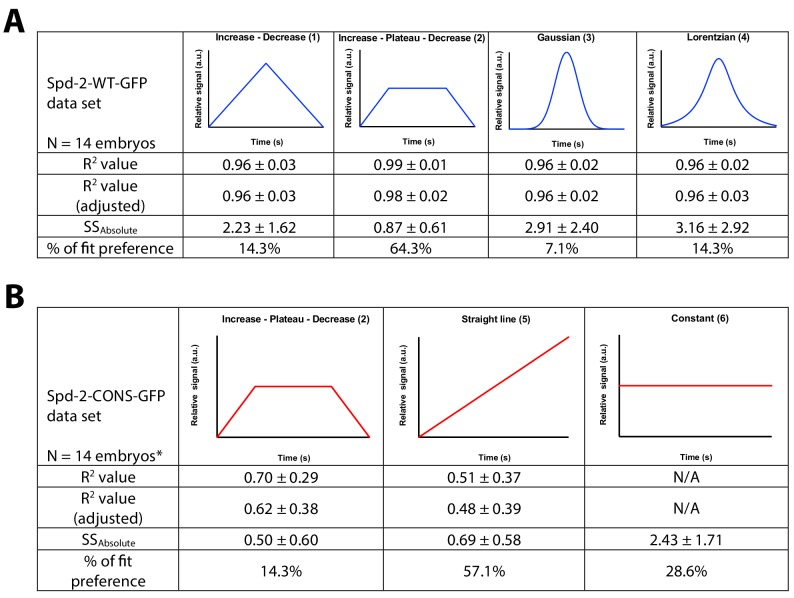
A schematic illustration of the models tested for the regression analysis of Spd-2-GFP dynamics during centrosome maturation.The Spd-2-GFP dynamic data for each individual embryo (Figure 8, and Figure 8—figure supplements 1 and 2) was assessed using the nonlinear regression (curve fit) analysis function in GraphPad Prism 7. The functions tested are illustrated schematically in the graphs. R2, adjusted R2, and absolute sum-of- square values are used as a measure for goodness-of-fit. (A) The data for WT Spd-2-GFP was fitted against four different functions to assess the most suitable model: (1) user-defined linear growth followed by linear decrease; (2) user-defined linear growth followed by plateau followed by linear decrease; (3) Gaussian function; (4) Lorentzian function. The preferred model was (2). (B) The data for Spd-2-CONS-GFP was fitted against the preferred model for the WT data (2), but the data seemed to be described better as a straight line, so it was also fitted against two additional models: (5) a standard straight line; (6) a user-defined linear constant line. The preferred model was (5), although the average slope value was nearly zero (−0.0005 ± 0.0054; mean ± SD), indicating that the appropriate model in practice would be (6), a constant line. *The data from two Spd-2-CONS embryos did not converge for the Increase - Plateau -Decrease model.